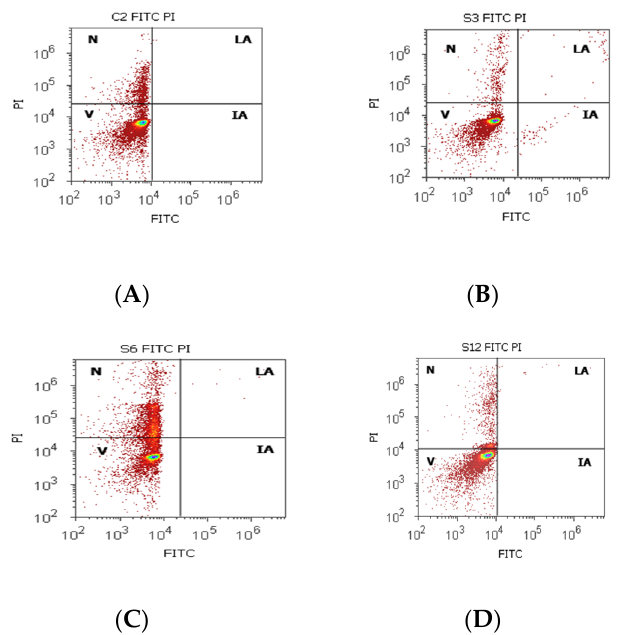
Figure 4. Cell apoptosis by Annexin V- FITC/ propidium iodide (PI) dual stain. Viability (V): ( A ) 83.50%; ( B ) 94.72%; ( C ) 68.79%; ( D ) 87.90%; Incipient apoptosis (IA): ( A ) 0.00%; ( B ) 0.54%; ( C ) 0.005%;